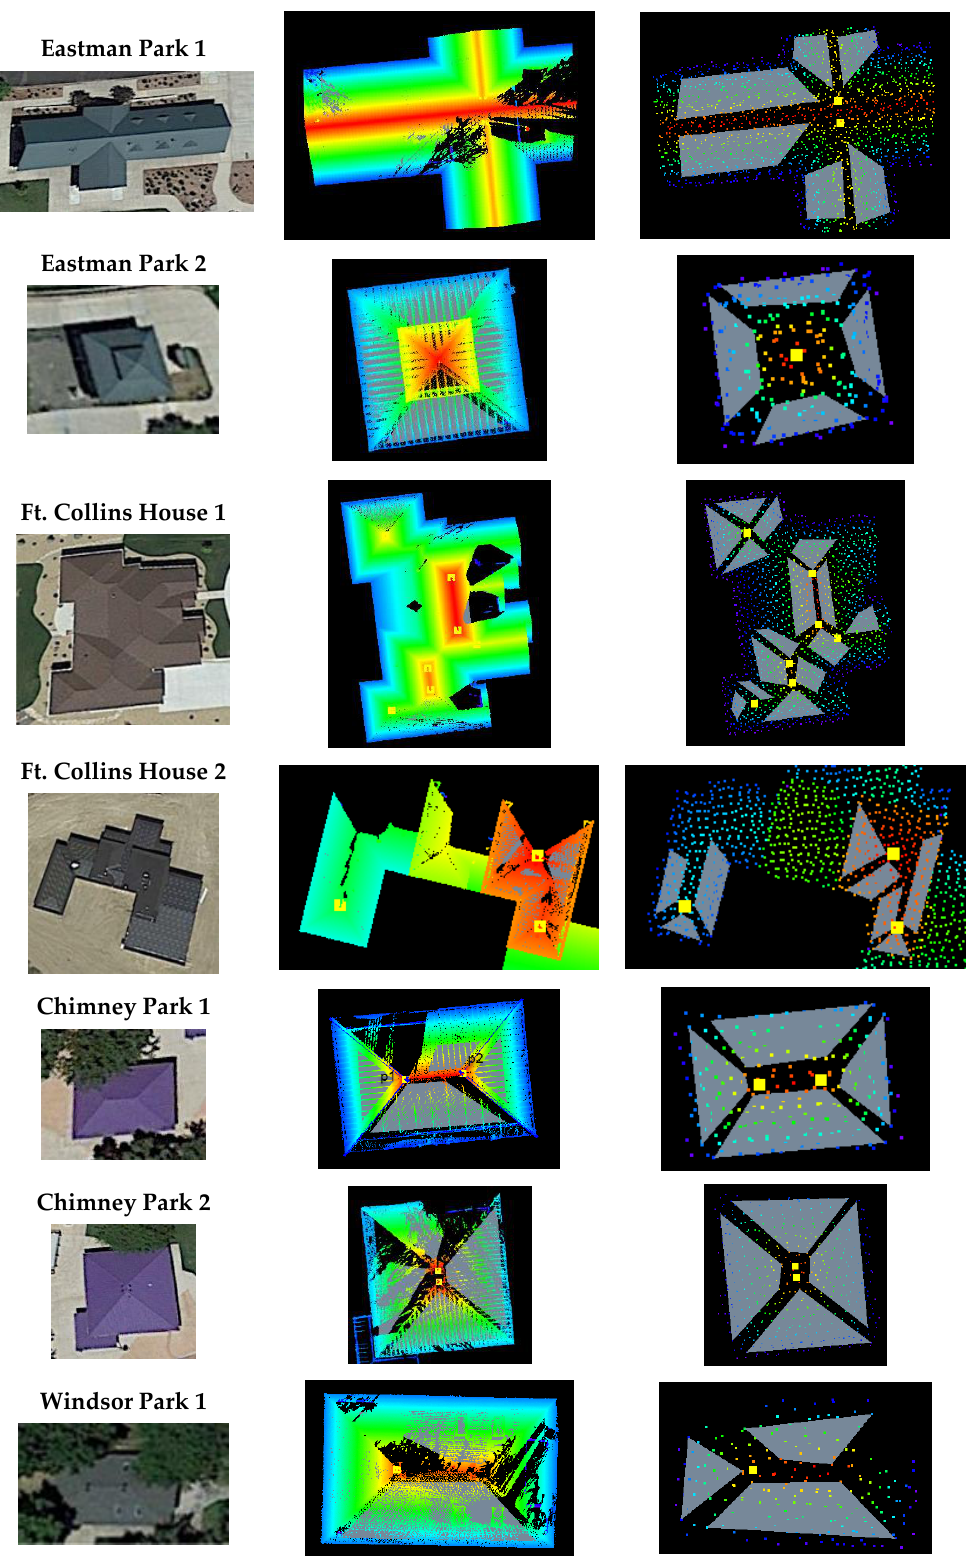
Figure 13. Three-plane intersection samples, high PPSM TLS data (middle column), low PPSM CountryMapper lidar data (third column). The intersection points are shown as yellow points.